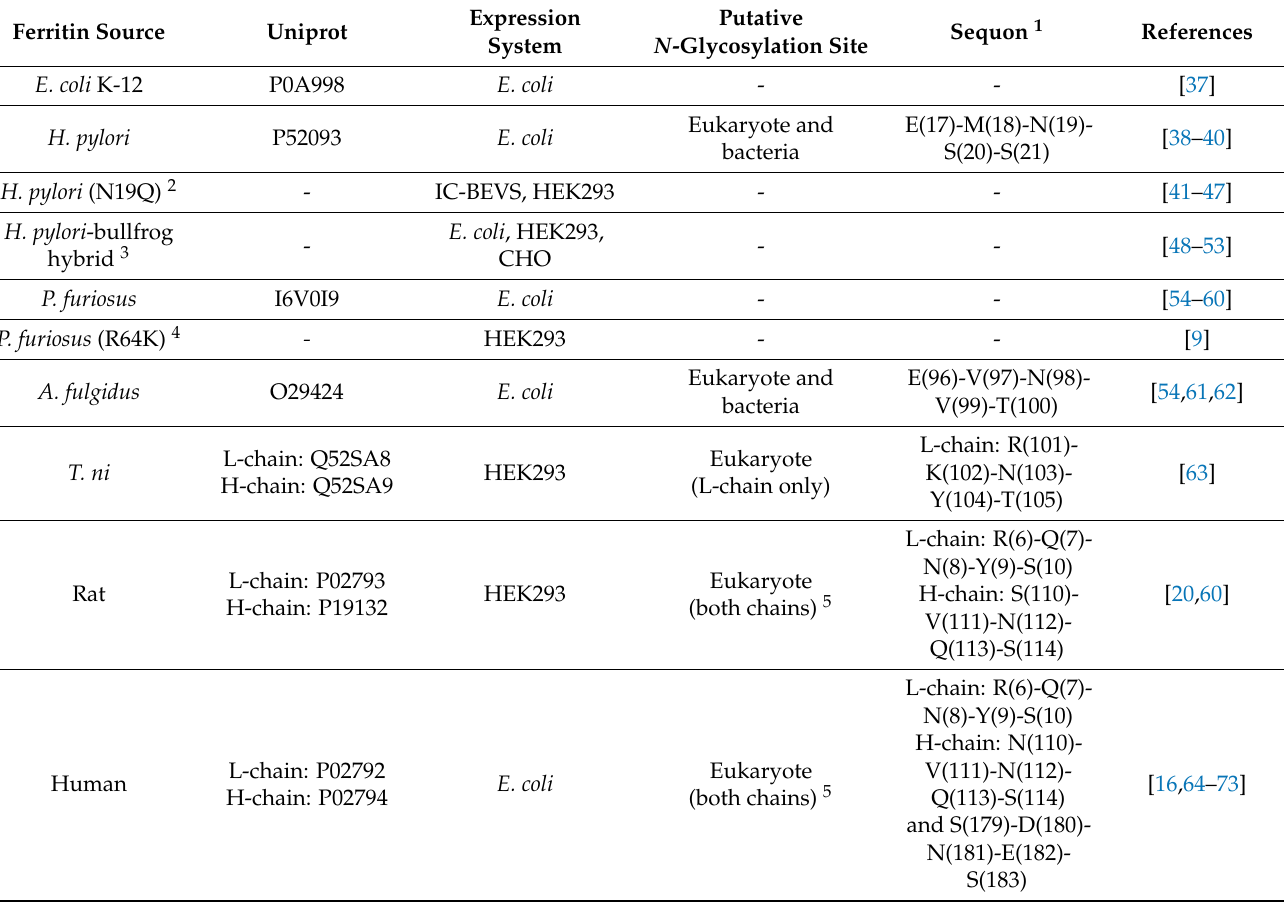
Table 1. Ferritin sources used for ferritin-based vaccine production, expression system, and putative N -glycosylation sites. Ferritin